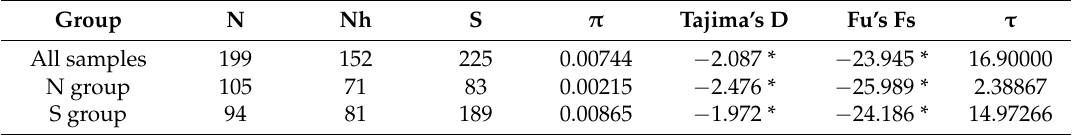
Table 1. Genetic diversity, neutrality tests, and statistics of mismatch distribution based on the concatenated mitochondrial dataset.